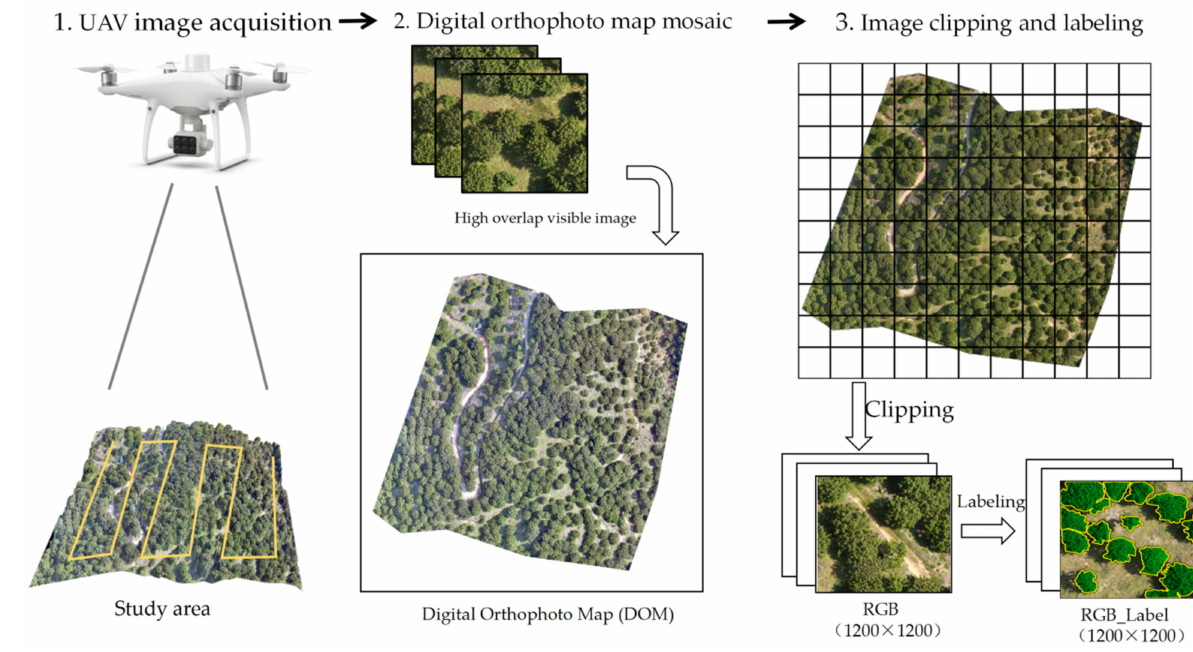
Figure 2. Flow chart of data set’s construction.